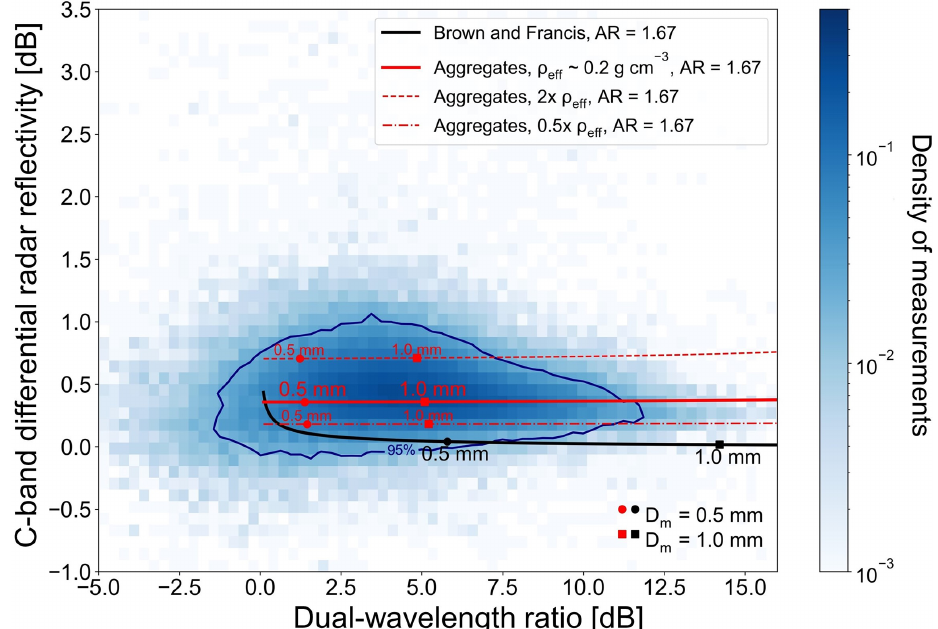
Figure 8. Radar observations between 0 and 5 ◦ elevation angles and scattering simulations for ice spheroids with m(D max ) corresponding to aggregates (red) and BF95 (black) for AR = 1 . 67, IWC = 0 . 50gm − 3 , and both radar beams simulated to be emitted horizontally. With scatters, the D m = 0 . 5mm and D m = 1 . 0mm are denoted. The 95th percentile of the 2D density histogram is drawn with a dark blue isoline. With red dashed and dash-dotted lines simulations for ice spheroids with double and half the density of aggregates are plotted.